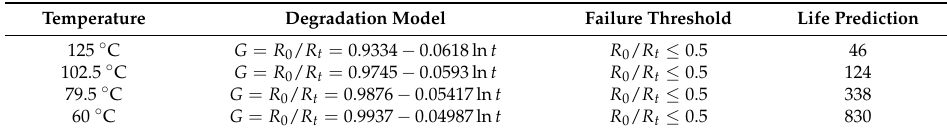
Table 3. Contact resistance degradation model and life prediction for different temperature stresses.